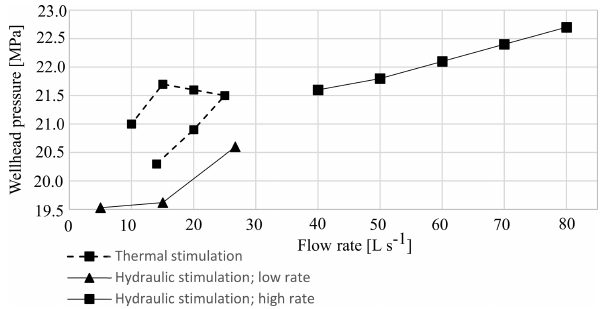
Figure 12. Stabilized wellhead pressure (MPa) as a function of flow rate (Ls − 1 ) measured during the hydraulic stimulation of the GRT-1 well in 2013 (after Baujard et al.,